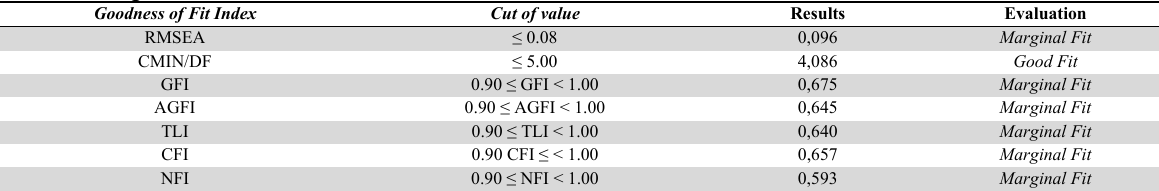
The results of goodness of fit Goodness of Fit